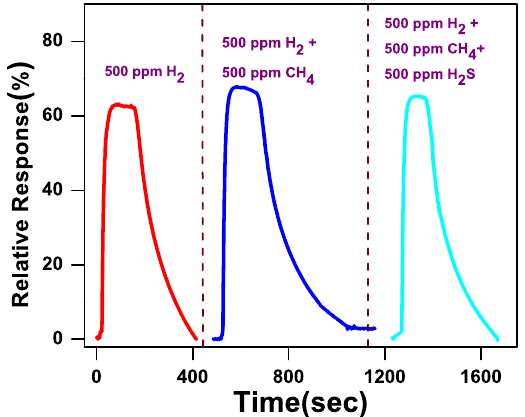
Figure 8. Cross selectivity response curve for various gases mixture (500 ppm H 2 , 500 ppm H 2 + 500 ppm CH 4 and 500 ppm H